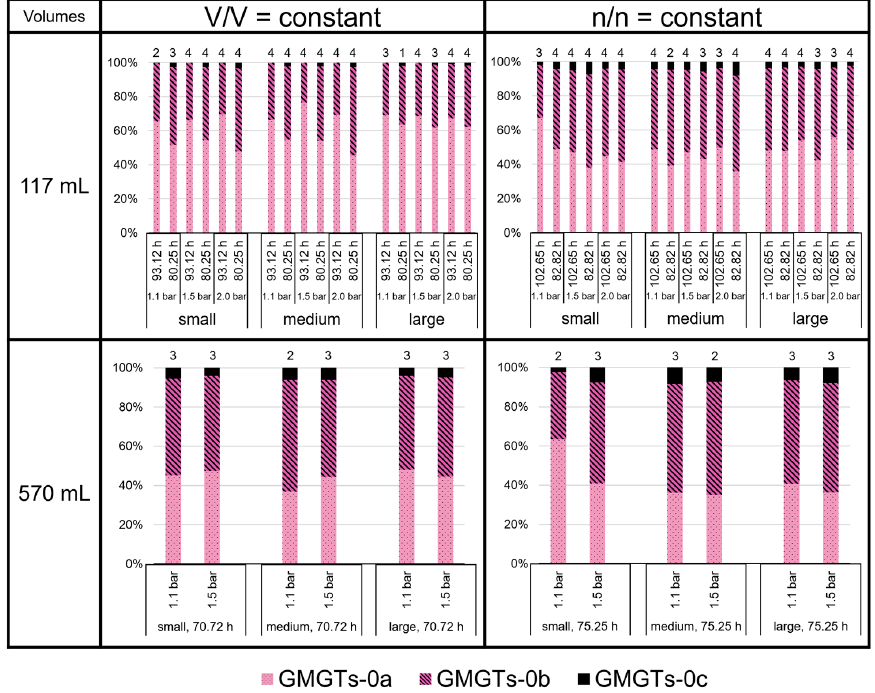
Figure 8. GMGT lipid ratios (two isomers each of GMGT-0a, GMGT-0b, and GMGT-0c) in M. marburgensis cultures. Pressure is given in bar relative to atmospheric pressure. Numbers above bars indicate number of samples. Samples quantified with 5- α -cholestane standard are indicated in Tables S4–S9.